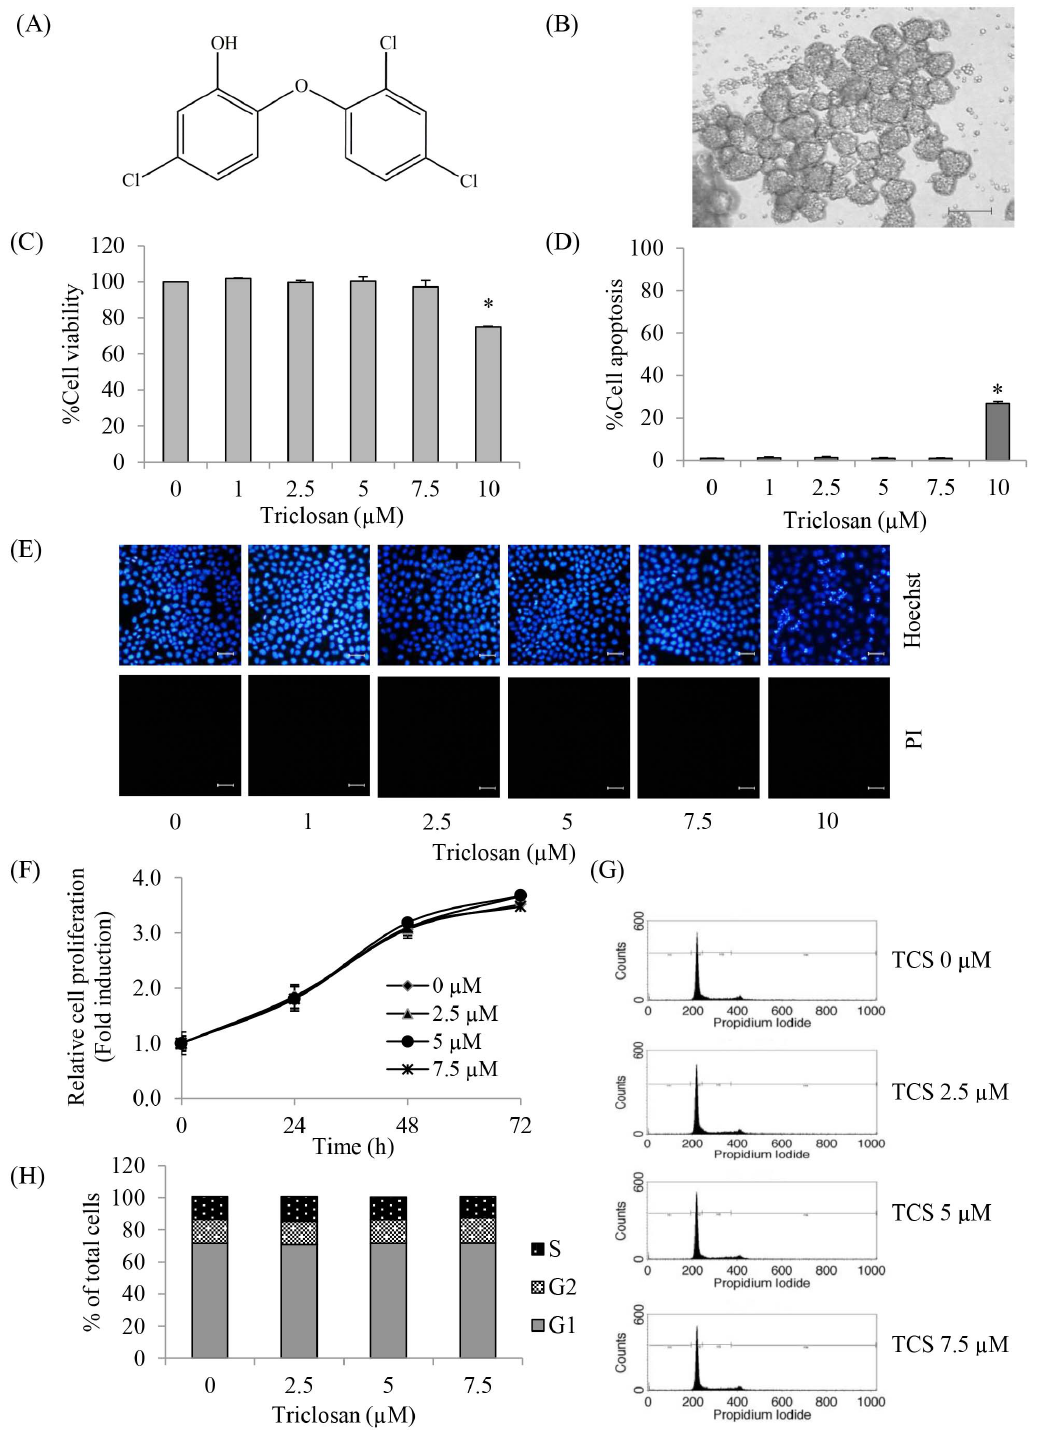
Figure 1. Cytotoxic effect and proliferative effect of TCS on anoikis resistant H460 cells. (A) The chemical structure of TCS. (B) Multicellular aggregation of anoikis resistant H460 cells. Scale bar is 1,000 m m. (C–D) After treatment with TCS (0–10 m M) for 24 h, the percentage of cell viability was determined by MTT assay and the percentage of apoptotic cells was detected by Hoechst33342 staining, respectively. Values are means of the three independent triplicate samples 6 SE. * P , 0.05 versus non-treated control. (E) After the indicated treatment, nuclear morphology of the cells was detected by Hoechst33342/PI co-staining assay and visualized under a fluorescence microscope. Scale bar is 50 m m. (F) Cells were treated with TCS (0–7.5 m M) for 24, 48 or 72 h. Cell viability was determined by MTT assay. The data represent the means of the three independent triplicate samples 6 SE. * P , 0.05 versus non-treated control at each indicated time. (G–H) Cells were treated with TCS (0–7.5 m M) for 48 h. Cell cycle of TCS- treated cells was determined by PI staining and flow cytometry. * P , 0.05 versus non-treated control.